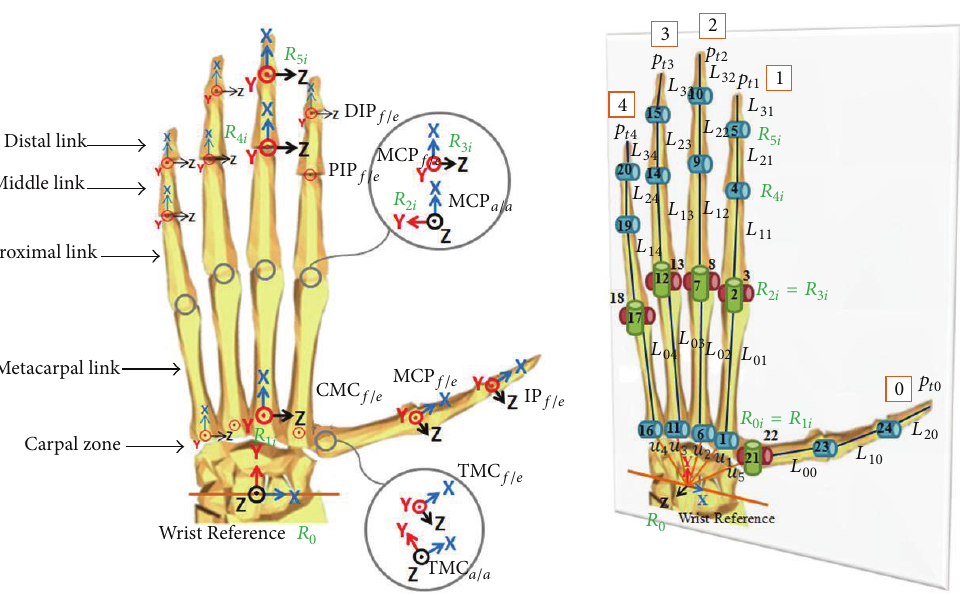
Figure 2: Kinematic configuration of the human hand. The thumb is defined by 3 links and 4 degrees of freedom whereas index, middle, ring, and little fingers are defined by 4 links and 5DoFs.